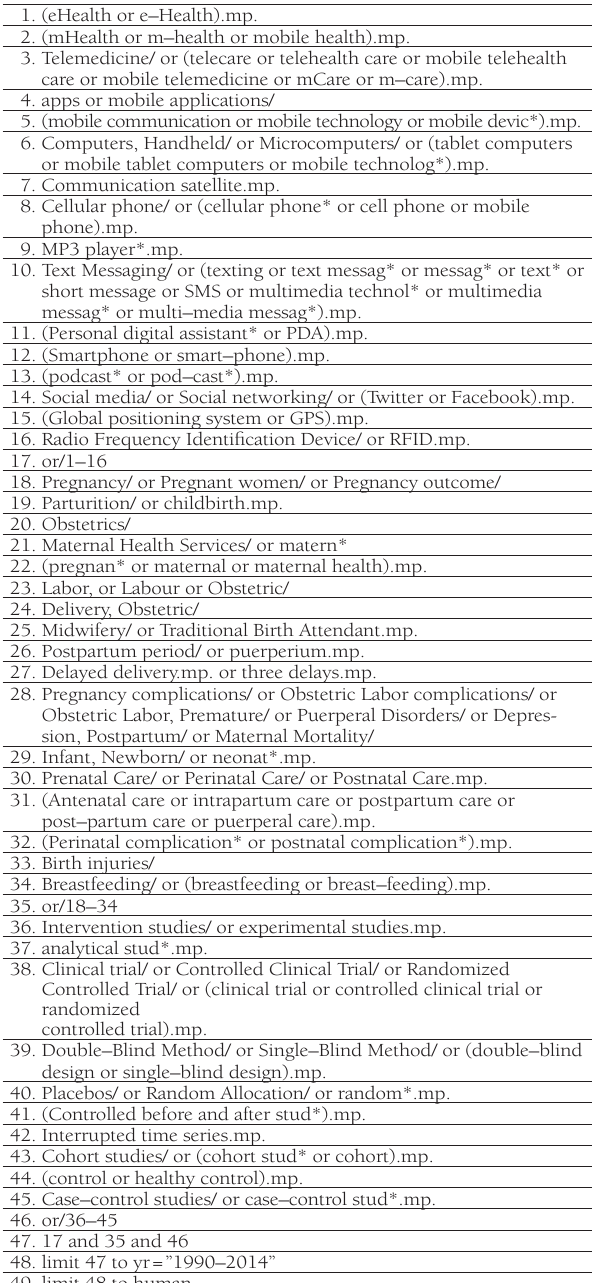
Table 1. Search strategy: Medline format Table 2. Search strategy: free–field format